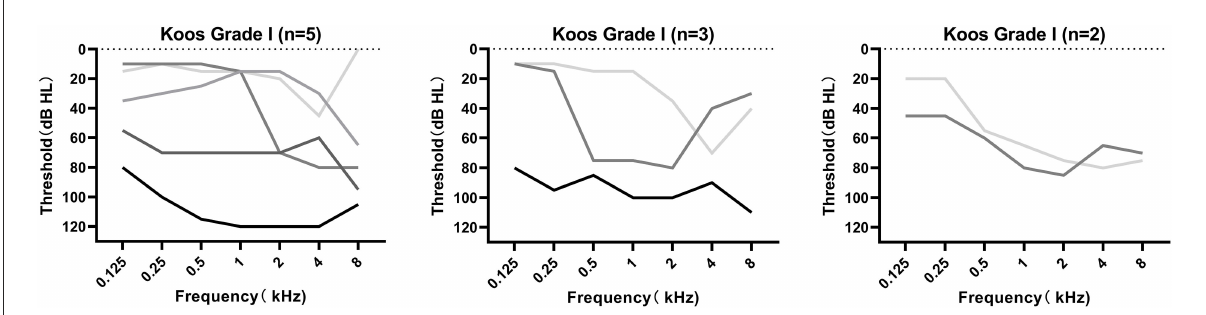
FIGURE2 Audiograms of the 10 patients with acoustic neuroma diagnosed as a sudden sensorineural hearing loss initially classified according to the Koos grading system. Audiometry found no consistent trend with regard to the Koos grading